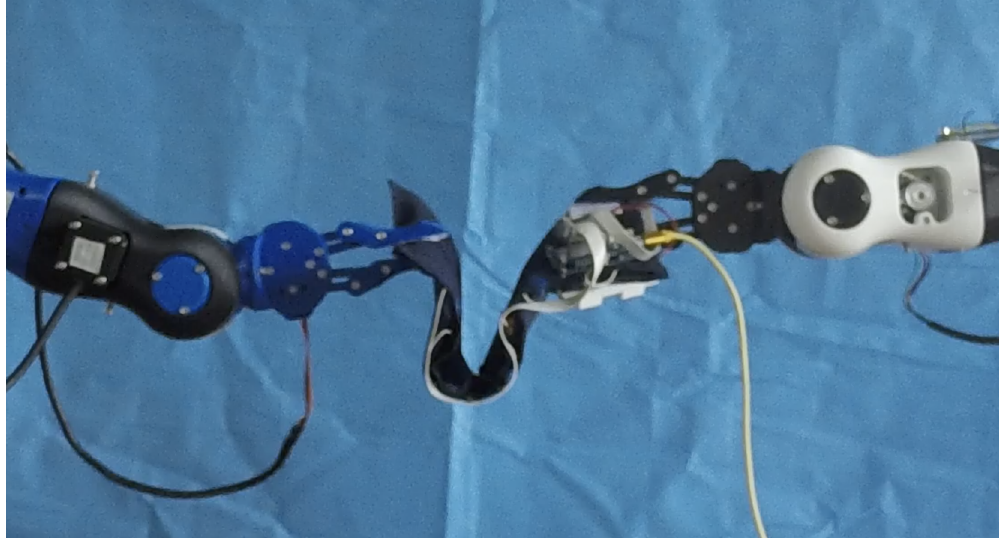
Figure 4. Example of the folding task on the real platform. The robotic arms are positioned in such a way that they cannot collide, making it physically impossible to fold the cloth fully. Thus, we do not require a fully folded state of the textile from the